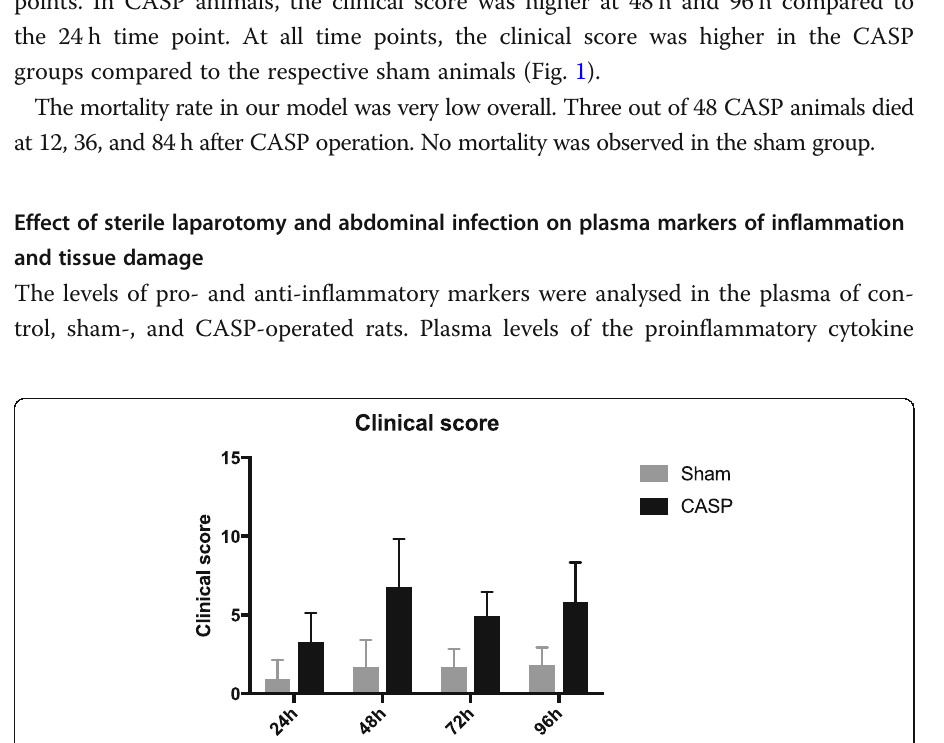
Fig. 1 Time course of clinical score in sham- (black bars) or CASP- (grey bars) operated animals. Clinical score was monitored and assessed according to Table 1 (see the “ Materials and methods ” section). Data are shown as mean ± SD ( n = 12, CASP 24 h n =